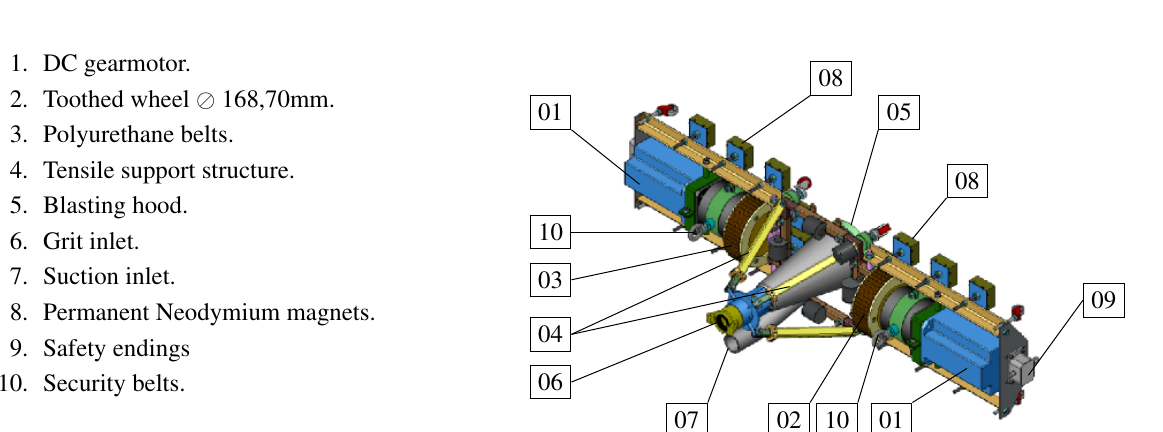
Figure 5. Robotic